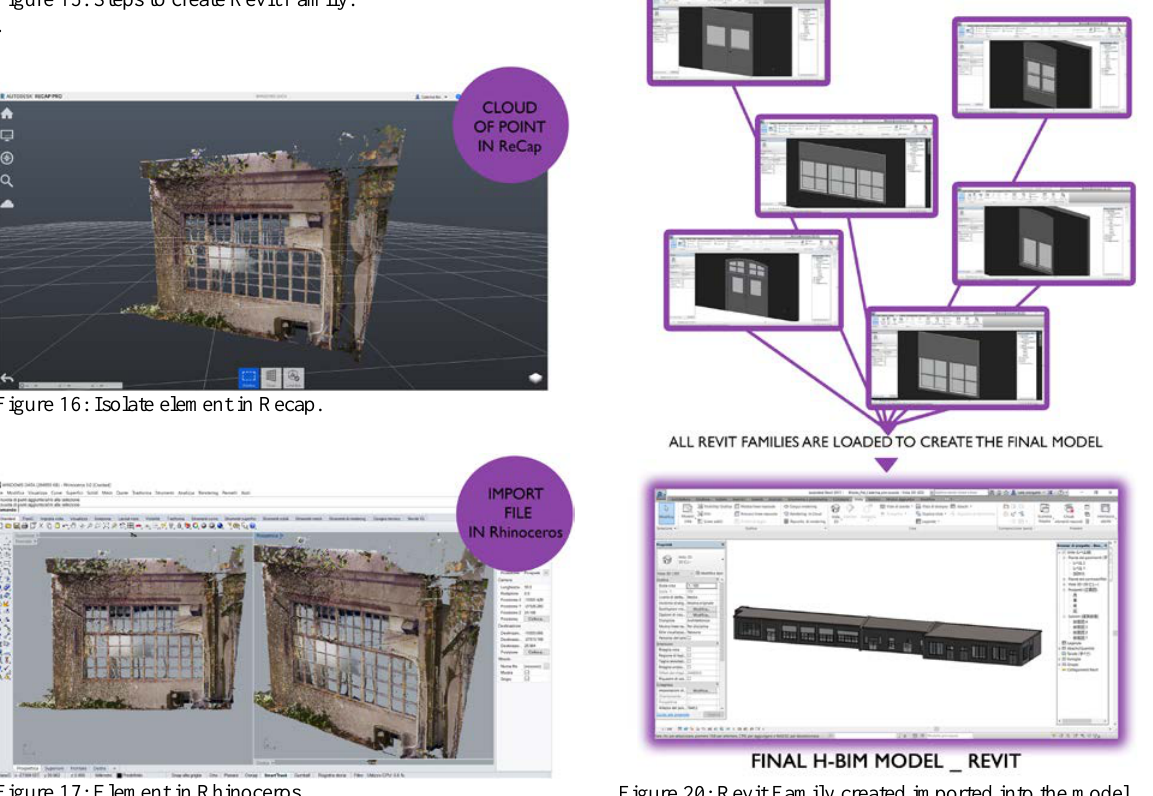
Figure 15: Steps to create Revit Family.